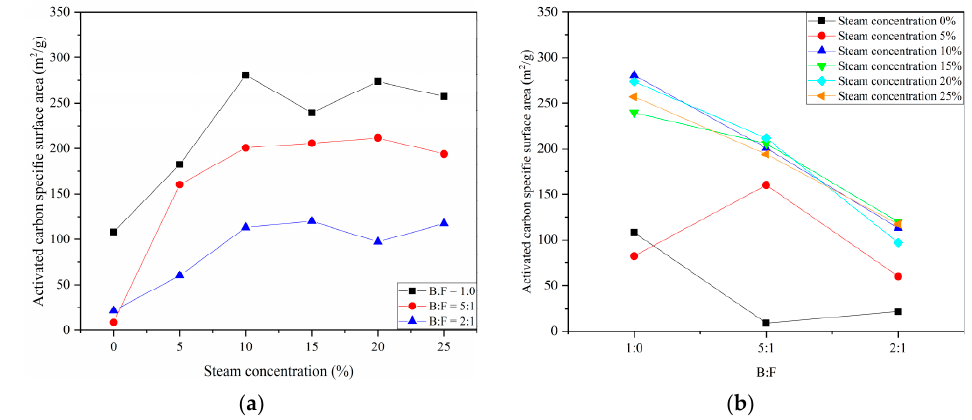
Figure 5. Variation trend of the specific surface area of activated carbon with respect to the steam concentration and raw material mixing ratio: ( a ) different steam concentrations and ( b ) different mixing ratios of raw materials.